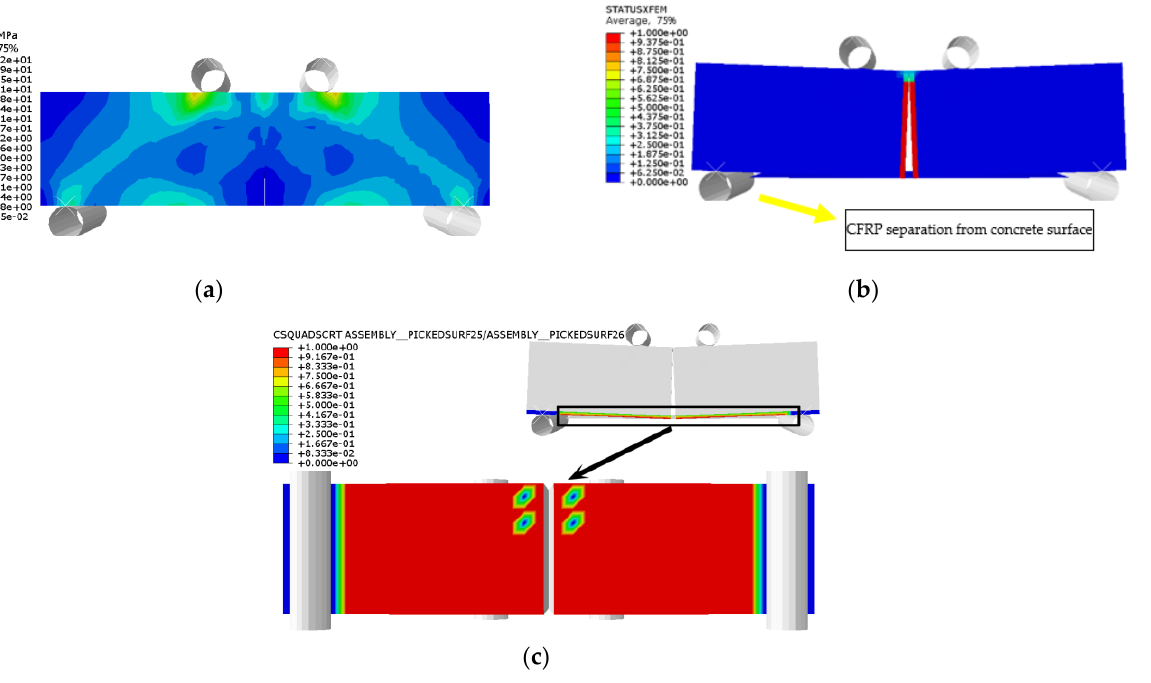
Figure 43. RFSF-100: ( a ) stress nephogram; ( b ) damage nephogram of prefabricated crack; and ( c ) damage nephogram of bonding surface.